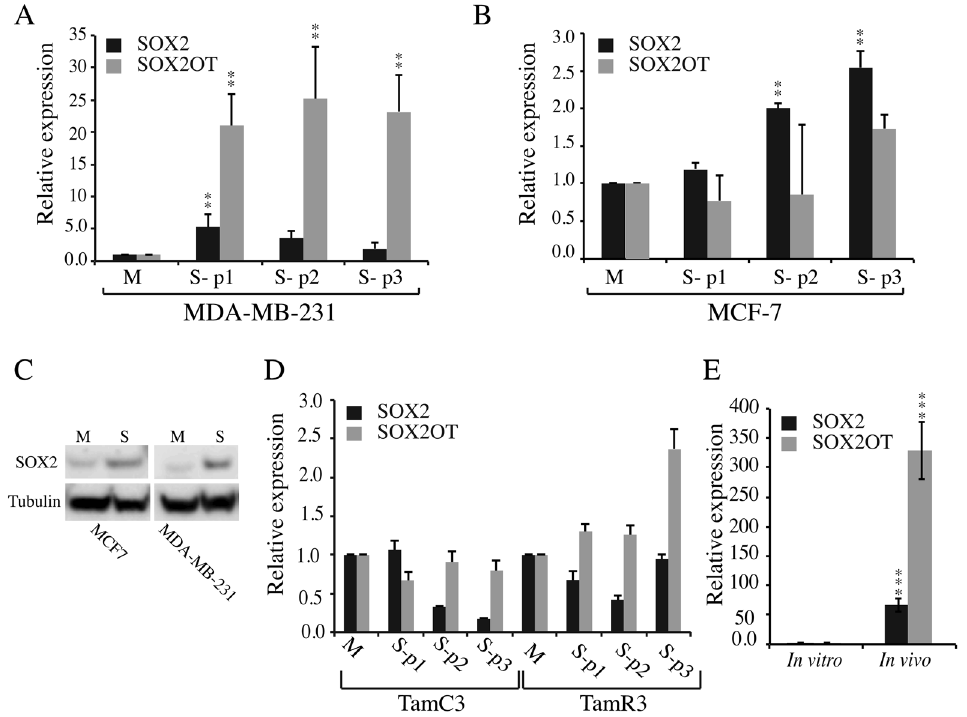
Figure 3. Expression on SOX2 and SOX2OT in breast cancer cell lines grown in suspension culture. A and B) Expression of SOX2 and SOX2OT in MDA-MB-231 (A) and MCF-7 (B) breast cancer cell lines cultured in suspension relative to the cells grown as monolayer was measured by qRT-PCR. Three consecutive passages of cells were grown in suspension as S-p1 to S-p3 respectively. M represents the expression in monolayer culture. Error bars represent the standard error of the mean of three biological replicates. C) Western blot analysis showing expression of SOX2 in MCF-7 and MDA-MB-231 cells grown as monolayers and in suspension. D) Expression of SOX2 and SOX2OT in TamC3 and TamR3 derivatives of MCF-7 grown in suspension relative to MCF-7 monolayer culture measured by qRT-PCR. Error bars represent standard deviations of three technical replicates. E) Expression of SOX2 and SOX2OT in monolayer MDA-MB-231-luc-D3H2LN cells ( in vitro ) and the same cells grown as orthotopic xenografts ( in vivo ) were measure by qRT-PCR. The error bars are standard error of the mean of six individual tumors. *, **, and *** represent p values of , 0.05, 0.01 and 0.001 respectively.